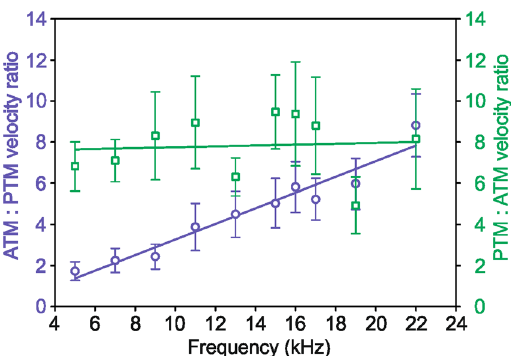
Figure 6. Tympanal membrane velocity ratios were determined for G . bimaculatus (green squares, N = 7) and L . bitaeniatus (blue circles, N = 10); data are means ± standard error of means. A linear regression was fitted to the data, revealing highly significant frequency dependency for L . bitaeniatus (R 2 = 0.939, p < 0.001, y = 0.38x) but not for G . bimaculatus (R 2 = 0.006, p = 0.83, y = 0.02x). Note that the ratio of ATM:PTM velocity for L . bitaeniatus and the inverse ratio of PTM: ATM velocity for G . bimaculatus is